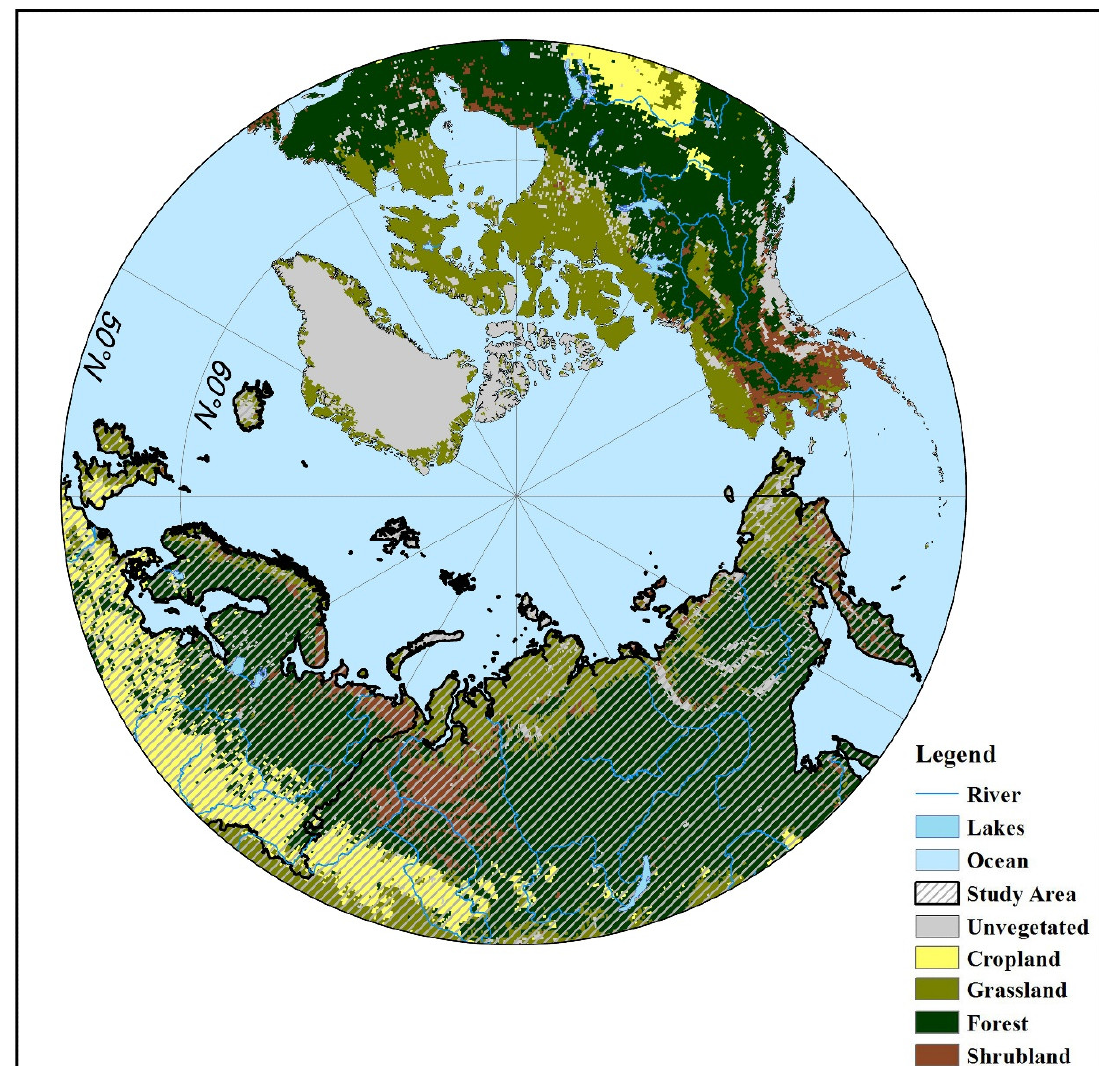
Figure 1. The study area and spatial distribution of land cover types of NEA. The land cover dataset was collected from the European Space Agency Climate Change Initiative Land Cover project and introduced in detail at the following section.